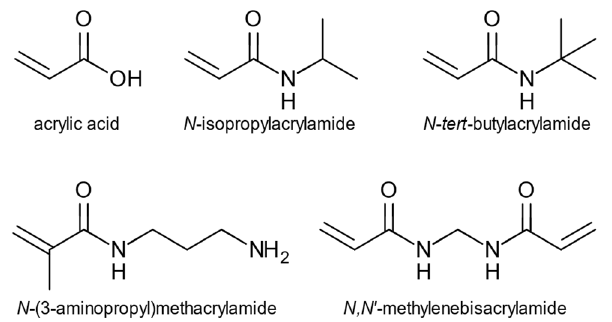
Figure 2. Monomers used for the synthesis of oxytocin-molecularly imprinted